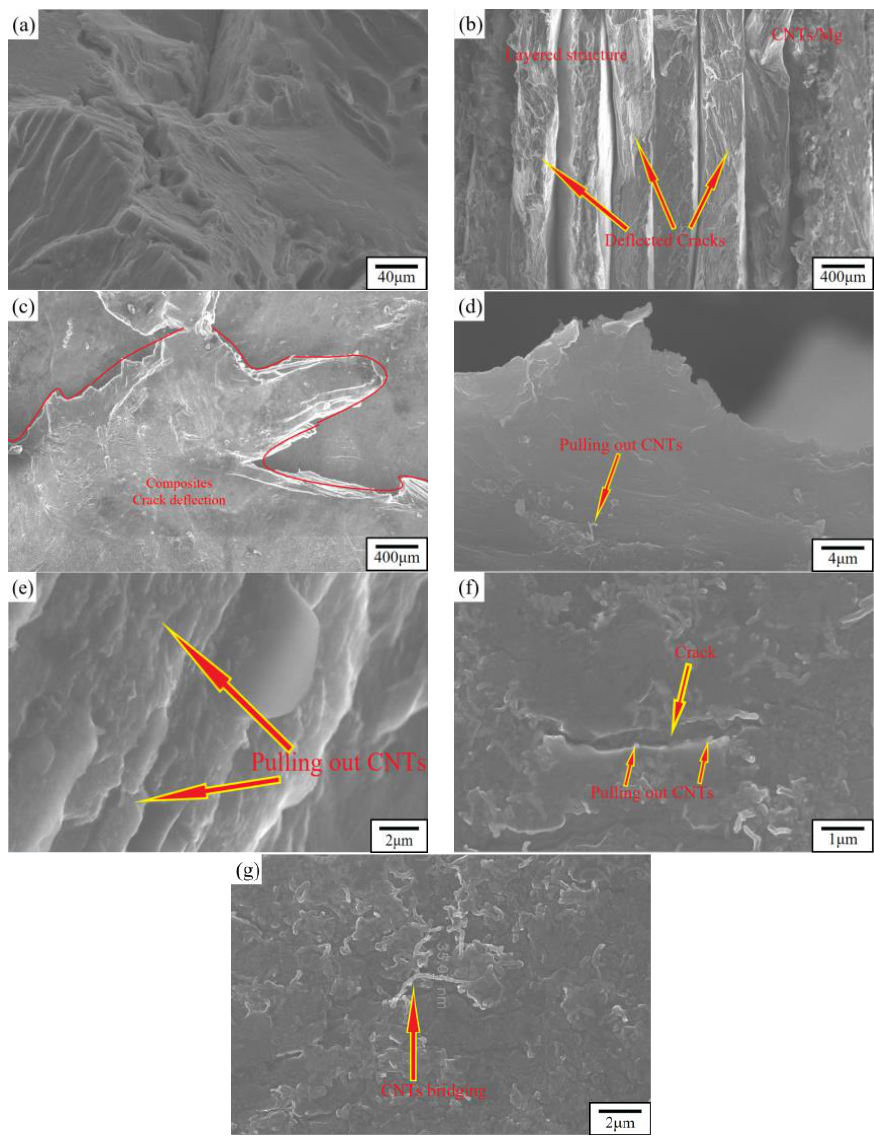
Figure 9. SEM image of Mg and CNTs/Mg composites: ( a ) the fracture surface of a single piece of Mg shows obvious cleavage fracture; ( b ) the fracture surface of the CNTs/Mg composite shows the deflection crack propagation of the CNT layer; ( c ) traces of crack deflection in the CNTs/Mg composite; ( d , e ) pull-out CNTs from the fracture; ( f ) pull-out CNTs from cracks; ( g ) carbon nanotube bridging and connecting Mg foil.